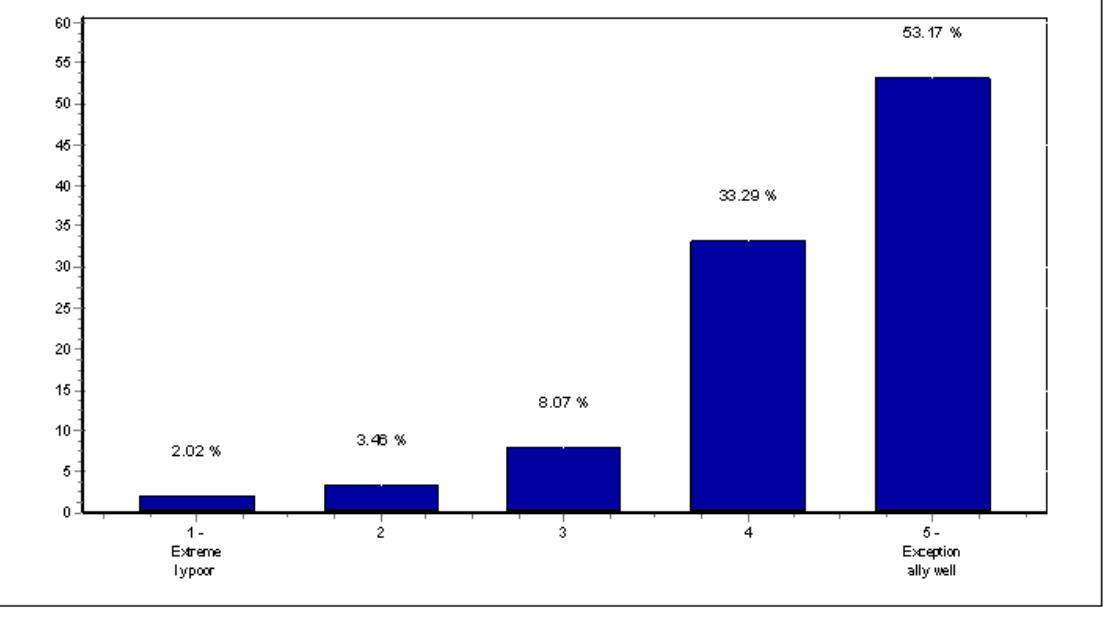
Fig. 7. Incentive to start own business Figure 7 indicates that approximately 86% of respondents indicated that the event incentivised them to start their own